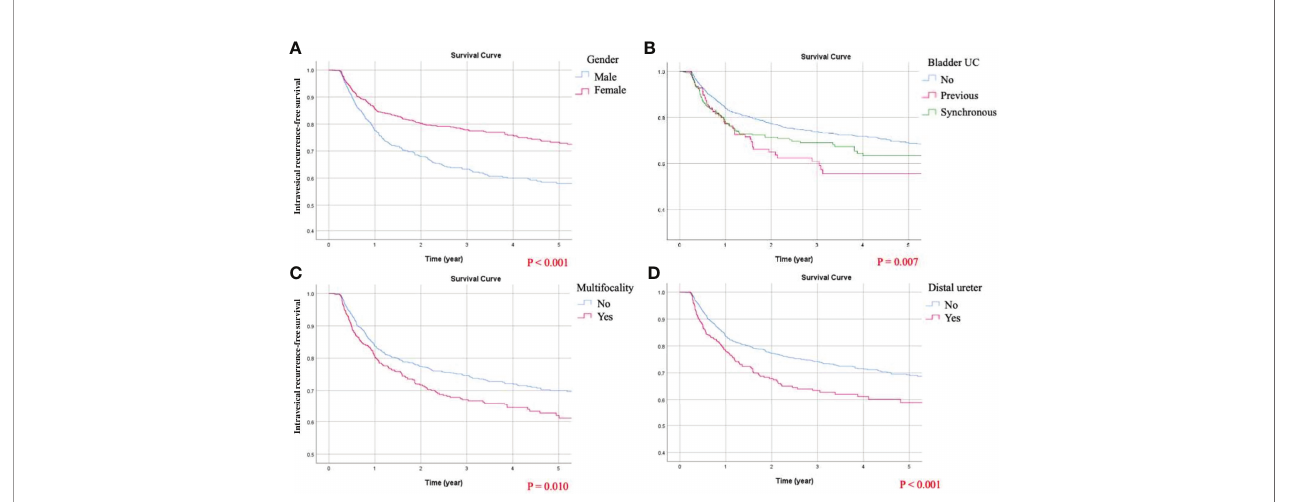
FIGURE 5 | Kaplan-Meier curves of intravesical recurrence-free survival (IVRFS) following adjustment for gender, preoperative hydronephrosis, middle ureteral, distal ureteral or bladder cuff urothelial carcinoma (UC), multifocal UCs, previous or synchronous bladder UC, tumor grading, cell type, and pathological T staging. Signi fi cant predicting factors for IVRFS included: (A) gender, (B) chronological history of bladder UC, (C) multifocality, and (D) tumor position at the distal